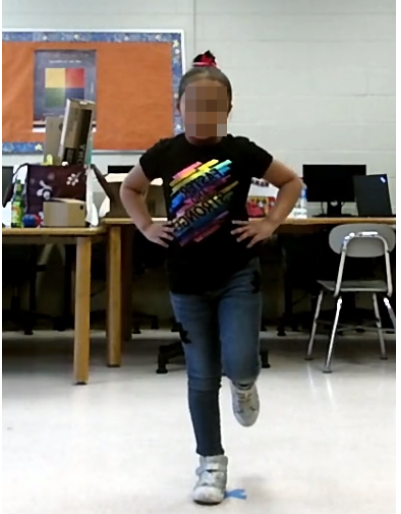
Figure 7. Example of stand on one